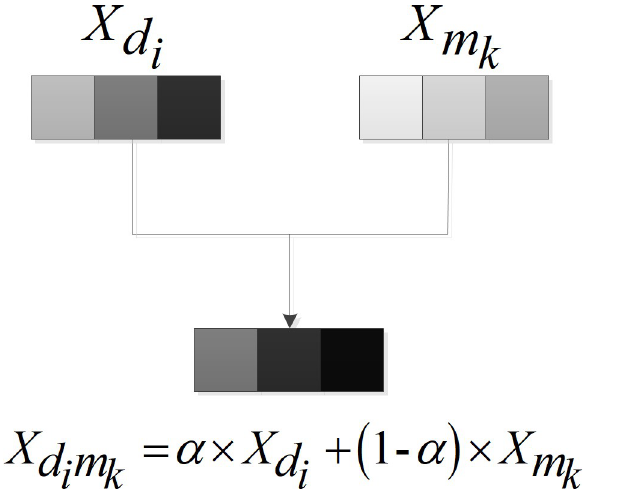
Fig 4. New feature component